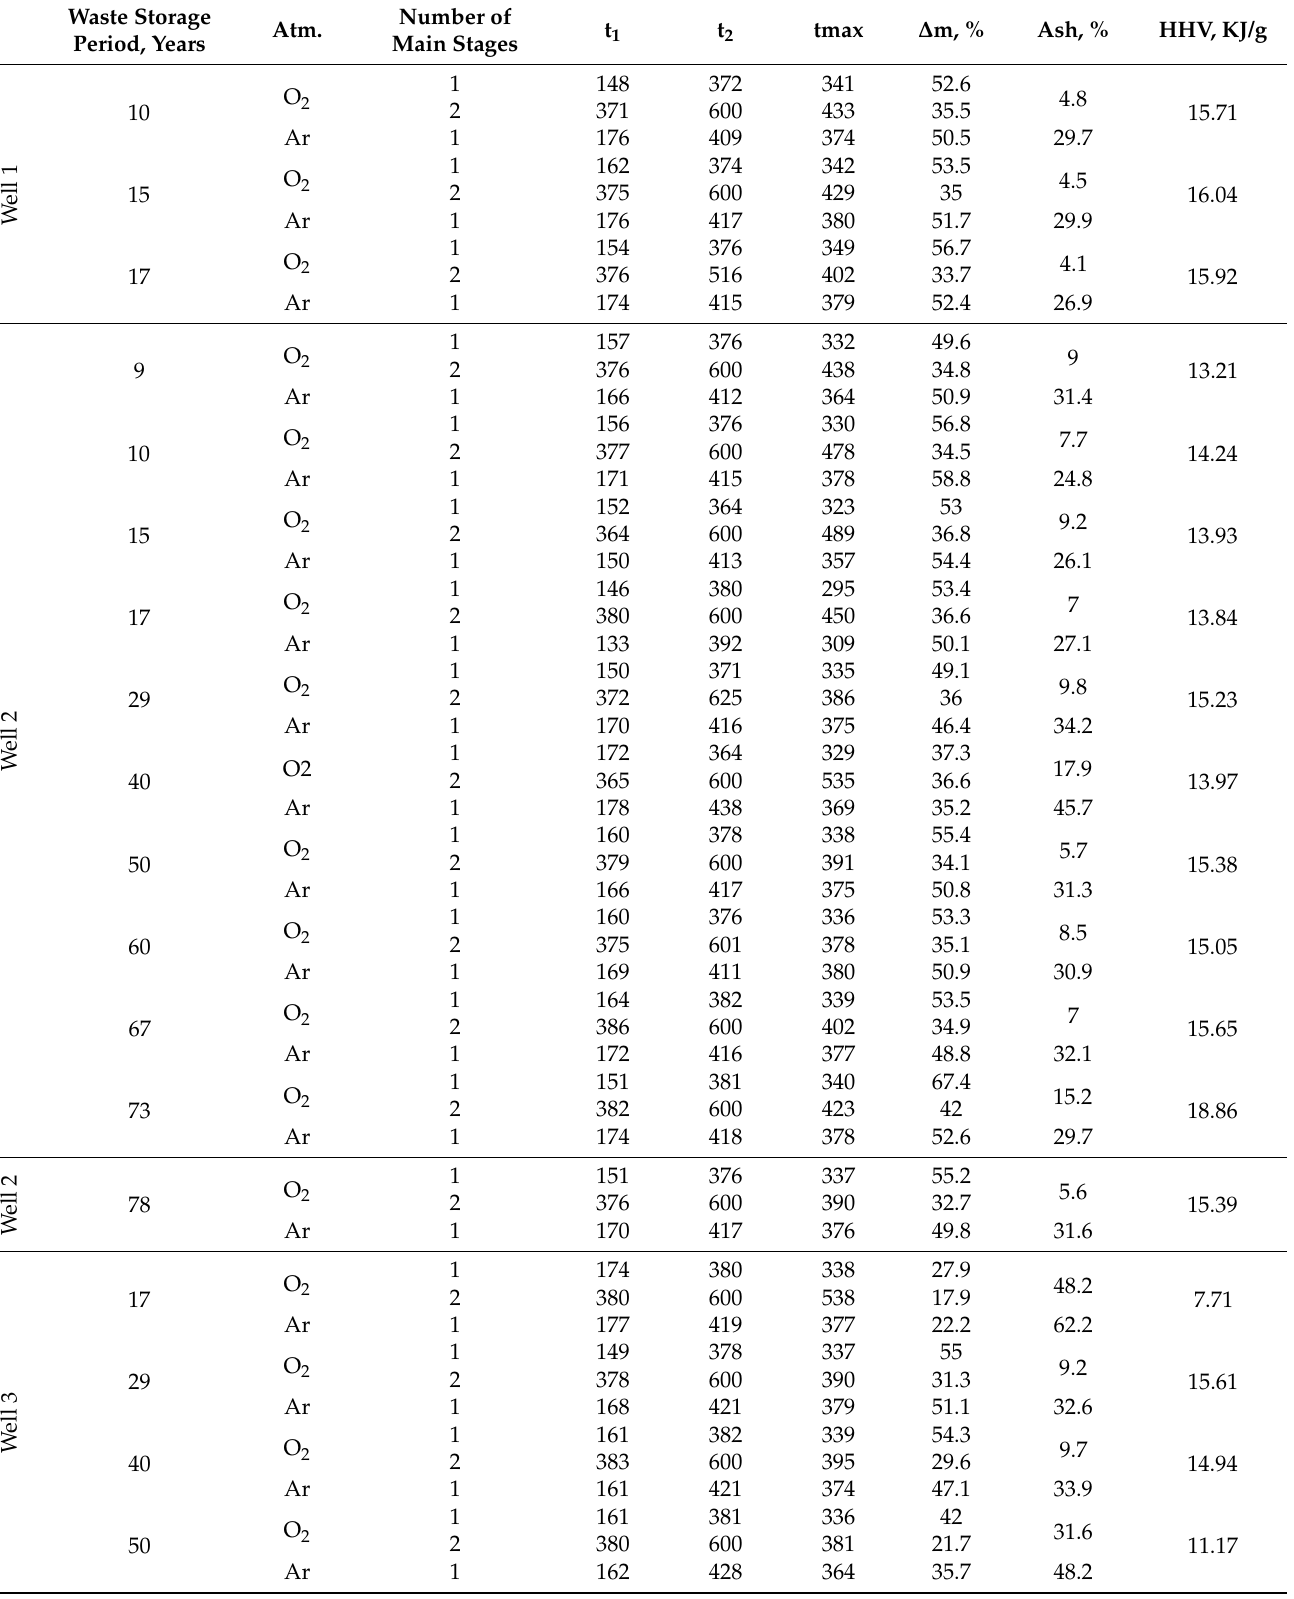
Table 3. Results of the thermal analysis of BWW samples in the air and in